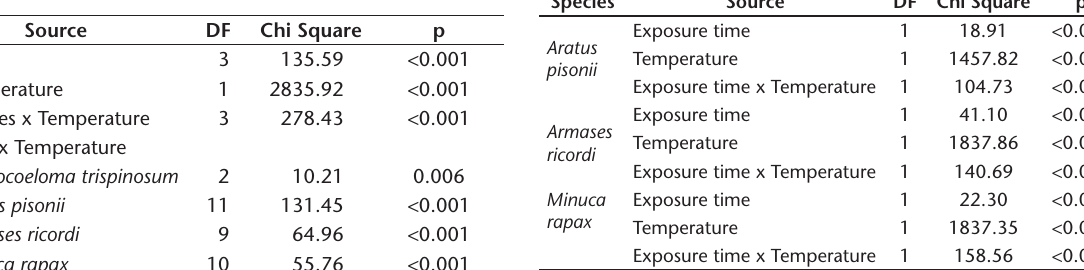
Table 2. Logistic regression of the larval survival after a 2 hours exposure for the four crab species, and the interaction between female and temperature for each species